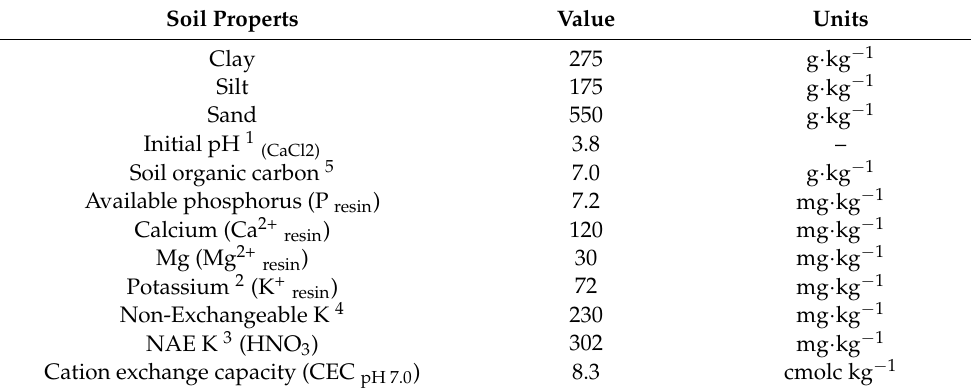
Table 1. Selected initial soil chemical characteristics (before liming amendment). Soil